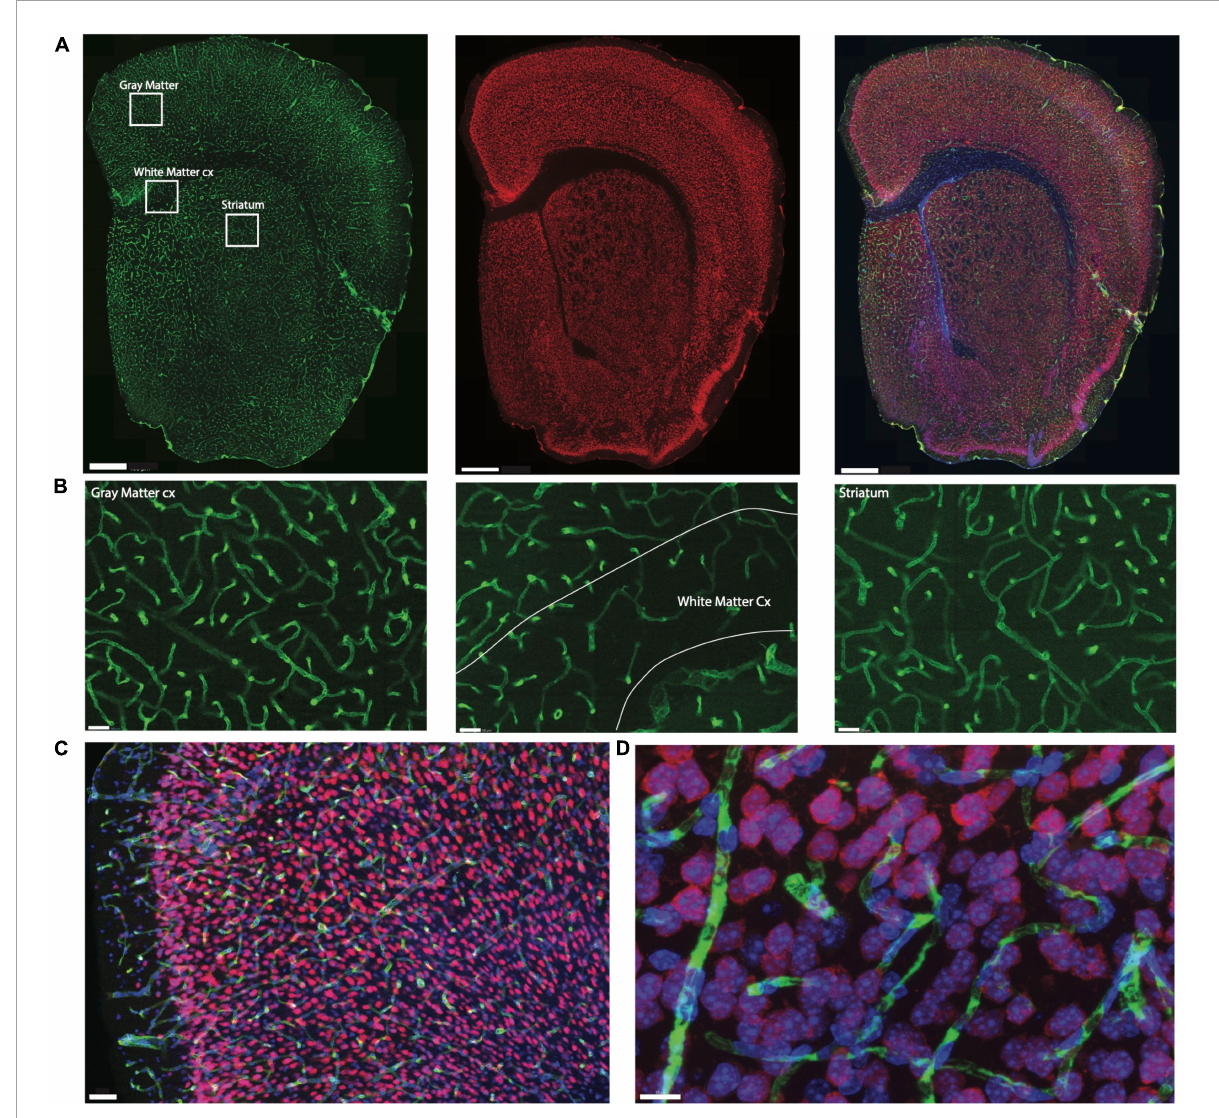
FIGURE1 Example of triple labeling for vasculature, neurons, and all cell nuclei. Shown is a coronal section of a mouse brain labeled by systemic injection of FITC-Dextran. (A) Coronal section of mouse brain showing microvasculature labeled with injection of FITC-dextran (left, green), neuronal nuclei labeled with NeuN-Cy3 (center, red), and all nuclei labeled with DAPI (right, blue in merged images). Scale bar, 400 µ m. (B) Zoom of insets in (A) using the 63 × objective with the thinner depth of field illustrating the extent of differences in capillary densities across brain sites. Scale bar, 50 µ m. (C) Section through cortical gray matter under 20 × magnification stained to reveal Collagen IV (green), NeuN (red) and cell nuclei (blue). Scale bar, 50 µ m. (D) Maximal projection image of 3D stack through cortical gray matter imaged under 63 × magnification. Scale bar, 10 µ